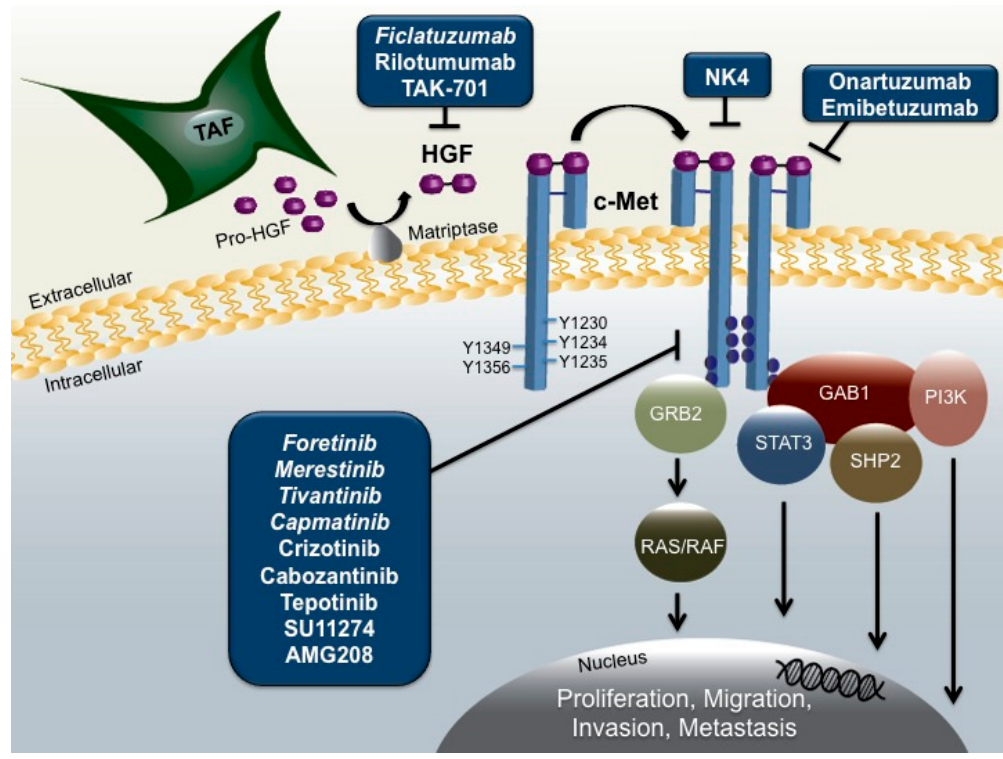
Figure 1. Targeted Inhibition of Hepatocyte Growth Factor (HGF)/c-Met Signaling in Head and Neck Squamous Cell Carcinoma (HNSCC). Secreted by local tumor associated fibroblasts (TAFs), pro-HGF is cleaved by membrane bound matriptase, enabling the heterodimer ligand to bind both the alpha and beta chain of the c-Met receptor. Upon binding, c-Met undergoes autophosphorylation and recruits adaptor molecules growth-factor-receptor-bound protein 2 (Grb2) and Grb2-associated binder 1 (Gab1) which further recruit oncogenic proteins SH2 containing protein tyrosine phosphatase (SHP2), signal transducers and activators of transcription-3 (STAT3), Ras/Raf, and phosphoinositide 3-kinase (PI3K), initiating signaling cascades promoting proliferation, migration, invasion, and metastasis. Inhibition of the pathway can be achieved through several strategies including anti-HGF monoclonal antibodies such as ficlatuzumab, the competitive HGF antagonist NK4, c-Met specific antibodies including onartuzumab, and c-Met tyrosine kinase inhibitors (TKIs) such as crizotinib. Italicized agents are in clinical development for